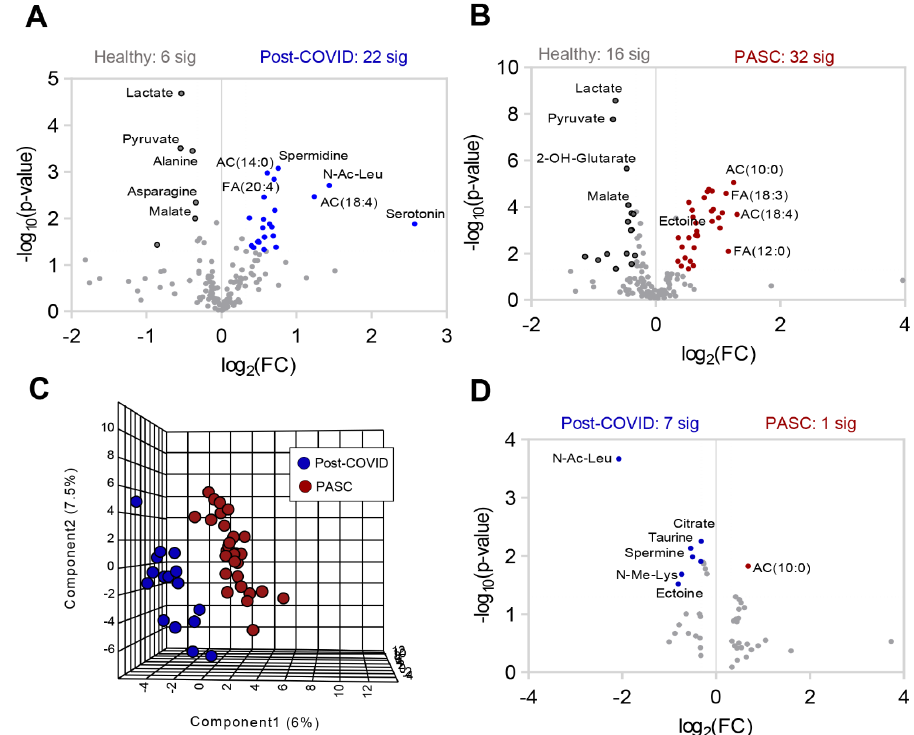
(Figure 3A); as well as saturated (C10, C12, C14, C16), monounsaturated (C14:1, C16:1, Figure 2. Differences in plasma metabolite profiles in individual groups. Volcano plot compari- C18:1), and poly- and highly unsaturated very-long-chain (C18:2, 18:3, 20:3, 20:4, 20:5 and Figure 2. Differences in plasma metabolite profiles in individual groups. Volcano plot comparisons sons to healthy plasma of ( A ) post-COVID without PASC and ( B ) PASC. C-D Comparison of post 22:6) free fatty acids (Figure 3B). BH FDR adjustment for all metabolites are reported in to healthy plasma of ( A ) post-COVID without PASC and ( B ) PASC. C-D Comparison of post COVID COVID without PASC vs. PASC shown by ( C ) PLS-DA and ( D ) volcano plot. Supplementary Table 1. The most significant changes among all three groups were noted without PASC vs. PASC shown by ( C ) PLS-DA and ( D ) volcano plot. in acylcarnitine 10:0, 14:1, 16:2, and 14:0 and fatty acids 18:2, 1:3, 14:0, 20:3, and 18:1.